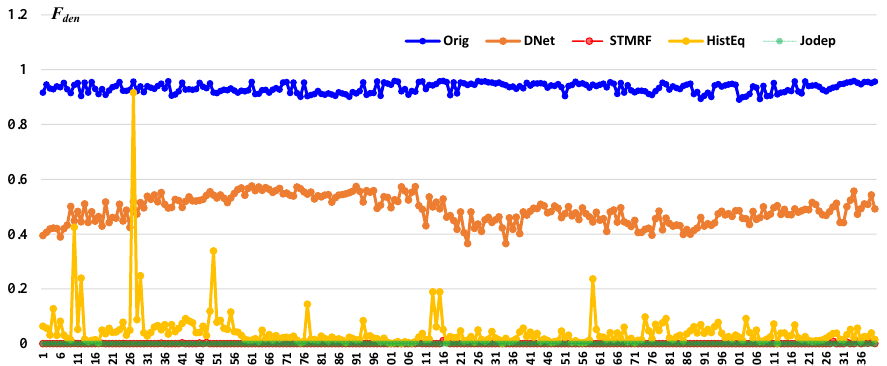
Figure 10. F den curves of the original video and the four different video defogging